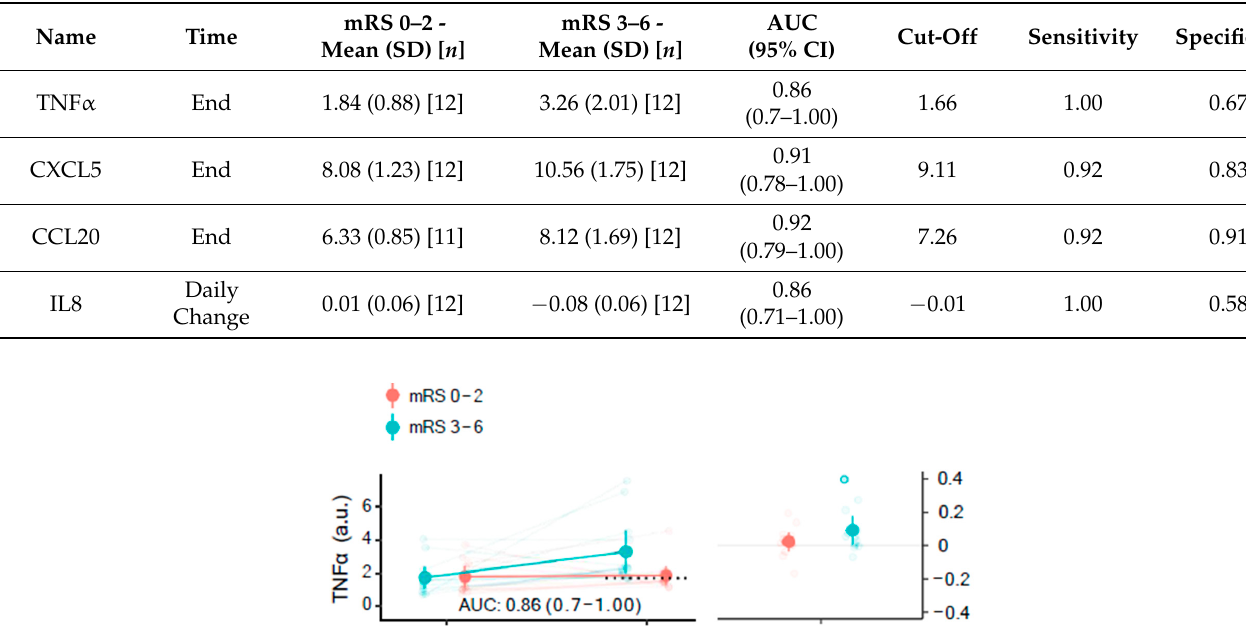
Table 2. Acceptable predictors of functional outcome measured by the Olink 96 inflammation panel. Inflammatory markers with AUC values above 0.7. AUC: area under the curve; CI: confidence interval; SD: standard deviation.